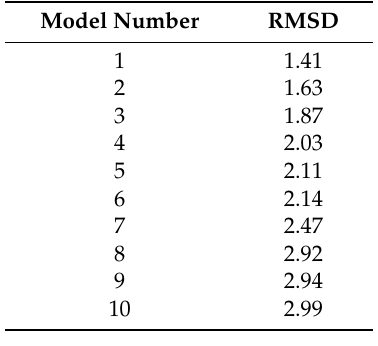
Table 4. Root mean square deviation (RMSD) values generated through pharmacophore comparison between the ligand-based and the receptor-based models. Model 1 displayed the lowest RMSD (Å).